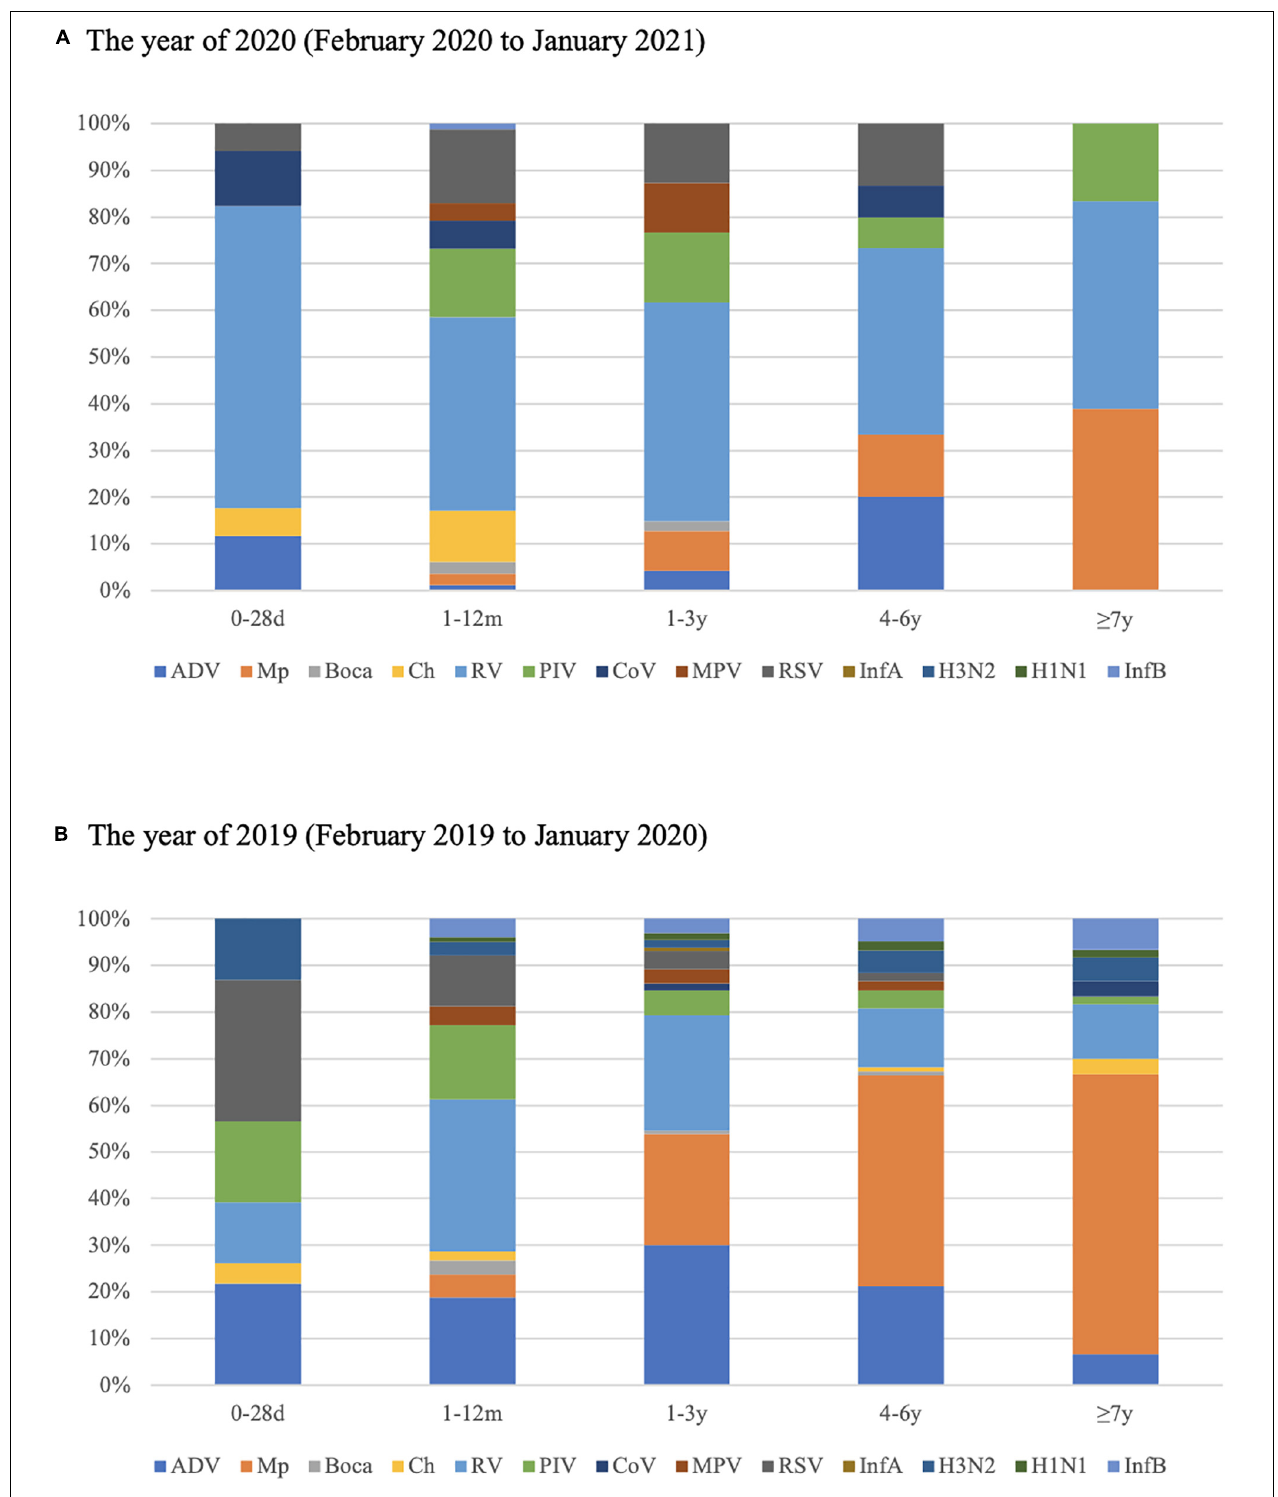
FIGURE 3 | Proportions of respiratory pathogens detected in 2020 (February 2020 to January 2021) (A) and 2019 (February 2019 to January 2020) (B) according to age group.